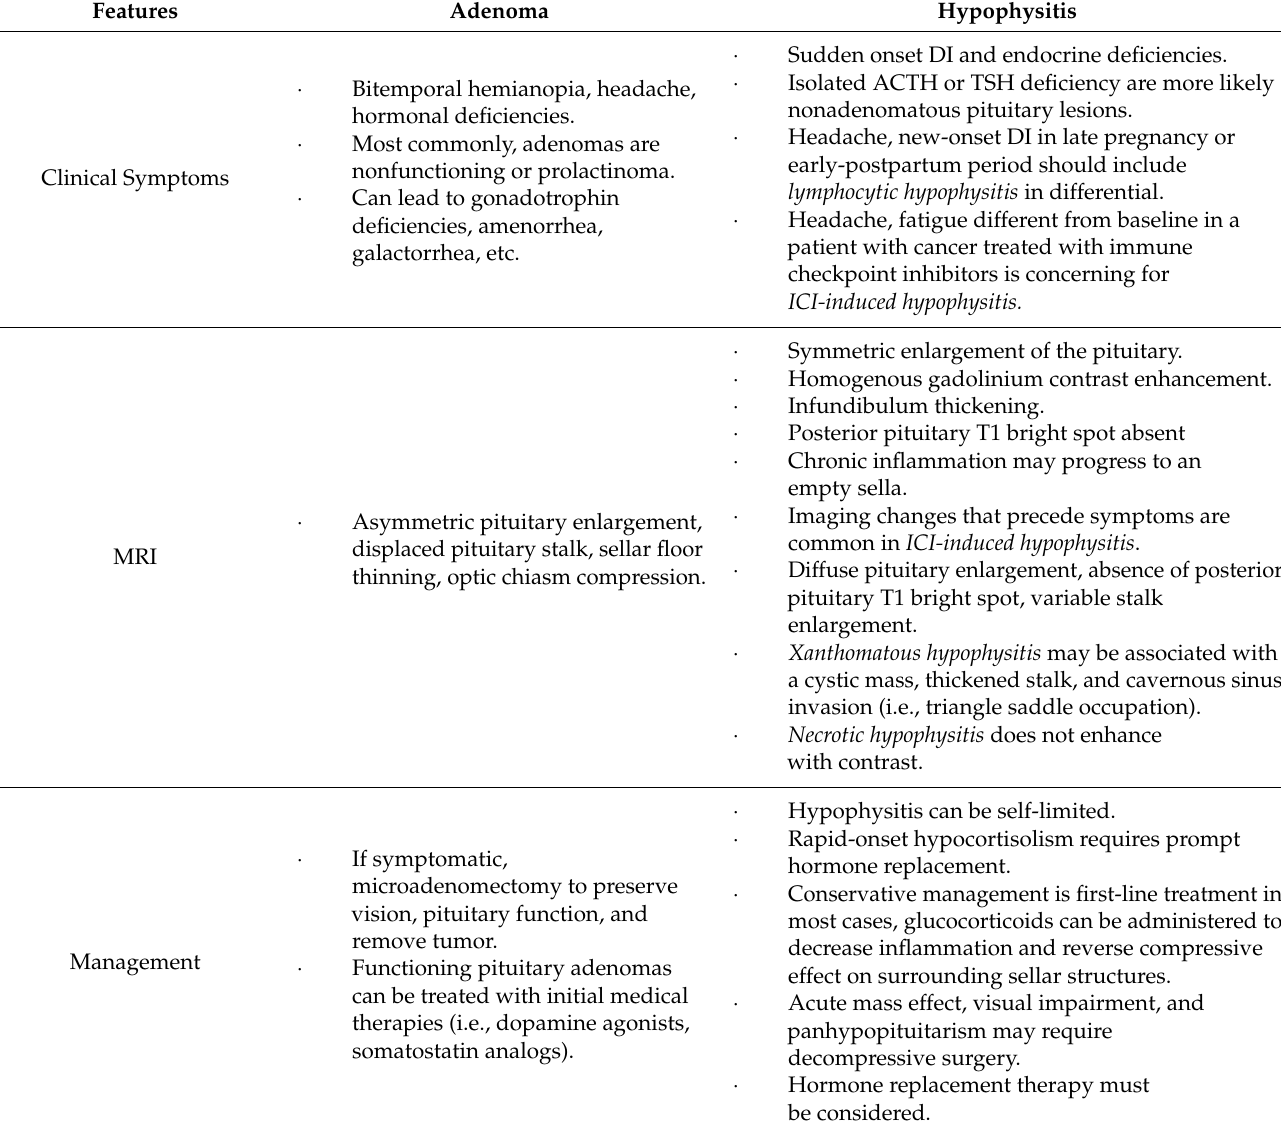
Table 3. Differentiation among common clinical and imaging features and management in hypophysi- tis versus pituitary